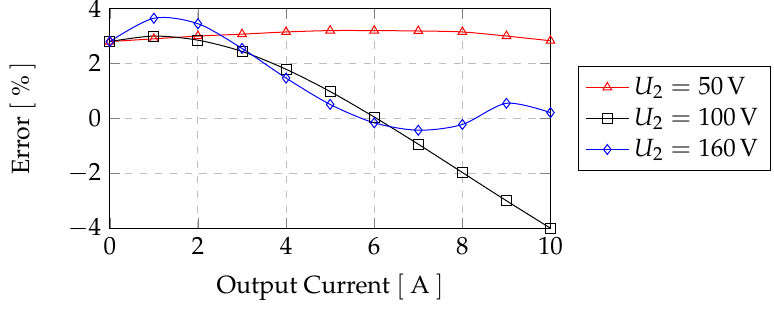
Figure 6. Output current error of VFM by approximation. (Parameters in Table